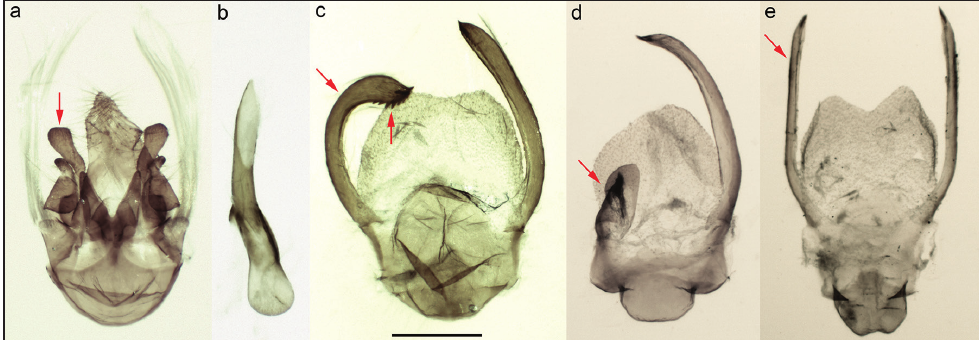
Figure 3. Male genitalia elements of S. orientalis , S. decorata and S. ornata . a-c. Male genitalia of S. orien- talis from Romania (Enisala fortress, Tulcea county, 4.ix.2015), prep. genit. 2318/Dincă. a. Genital armature. b. Aedeagus. c. Sternum A8. d. Sternum A8 of male S. decorata , Romania (Enisala fortress, Tulcea county, 10.vii.2013), prep. genit. 2405/Dincă. e. Sternum A8 of male S. ornata , Romania (Enisala fortress, Tulcea county, 24.viii.2016), prep. genit. 2417/Dincă. Scale bar is 0.5